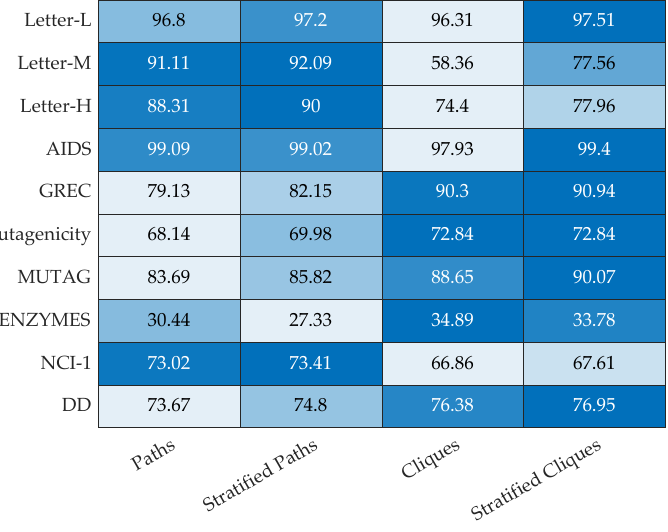
Figure 1. Accuracy on the test set (in percentage).